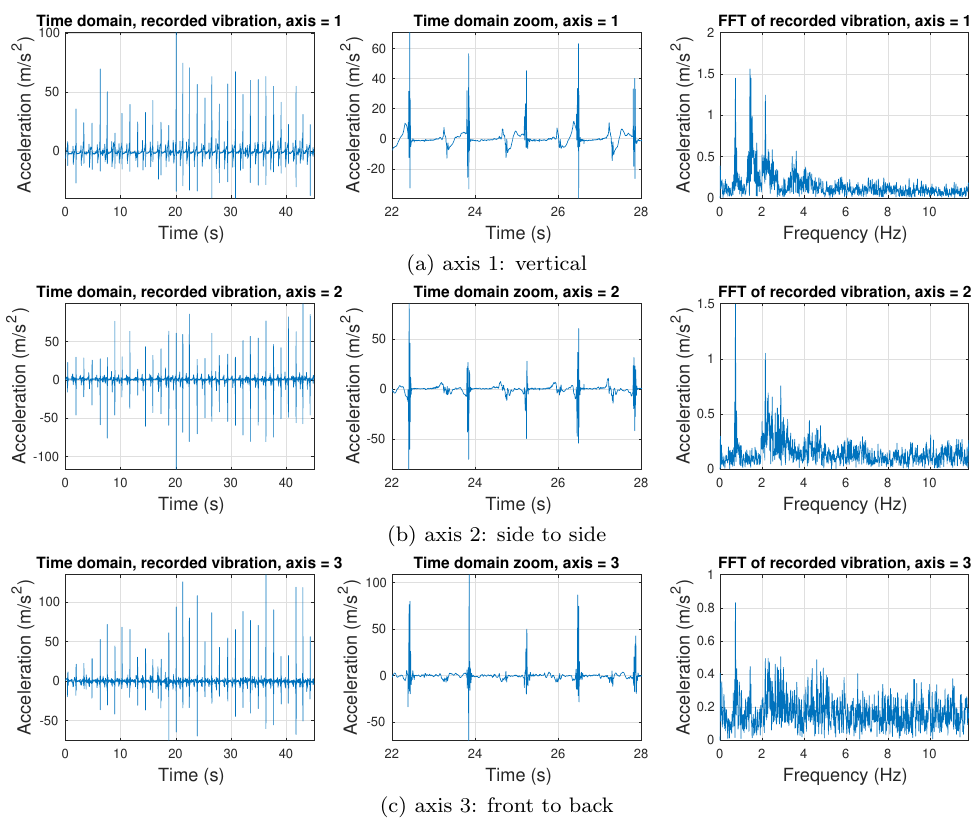
Figure 6: Walking with 20 kg weight on right hand Figure 7. Analysis of gait acceleration in all three axes with 20 kg weight in the right hand to simulate lopsided